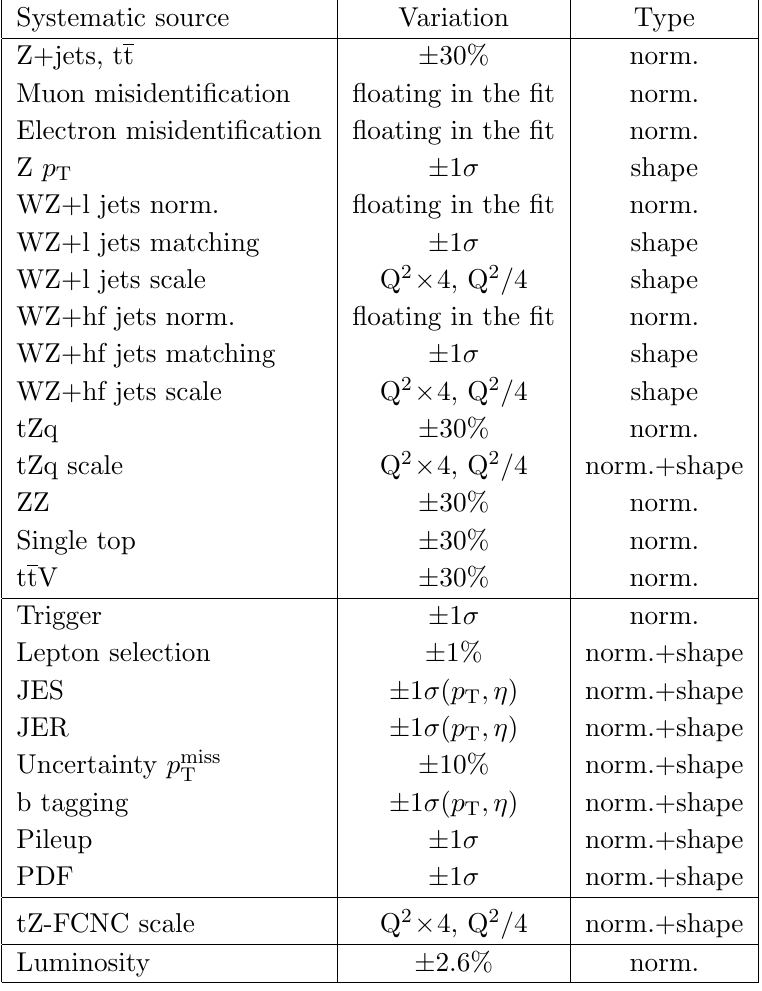
Table 3 . The systematic sources, variation and type, which represent how the uncertainty is treated in the likelihood (cid:12)t.